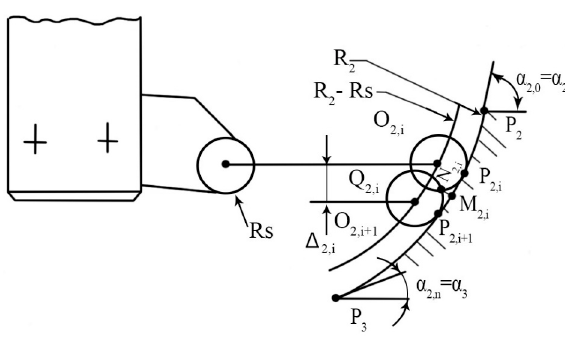
Figure 3. The occurrence of the deviation of the geometric shape-generator of the curve. In this context, the size of the segment O 2 O 2 ′ has values that vary depending on the position on the P 2 P 3 arc between the limit positions corresponding to α 2,0 → α 2 and α 2, n → α 3 ; this modifies the deviation (Figure 4a).